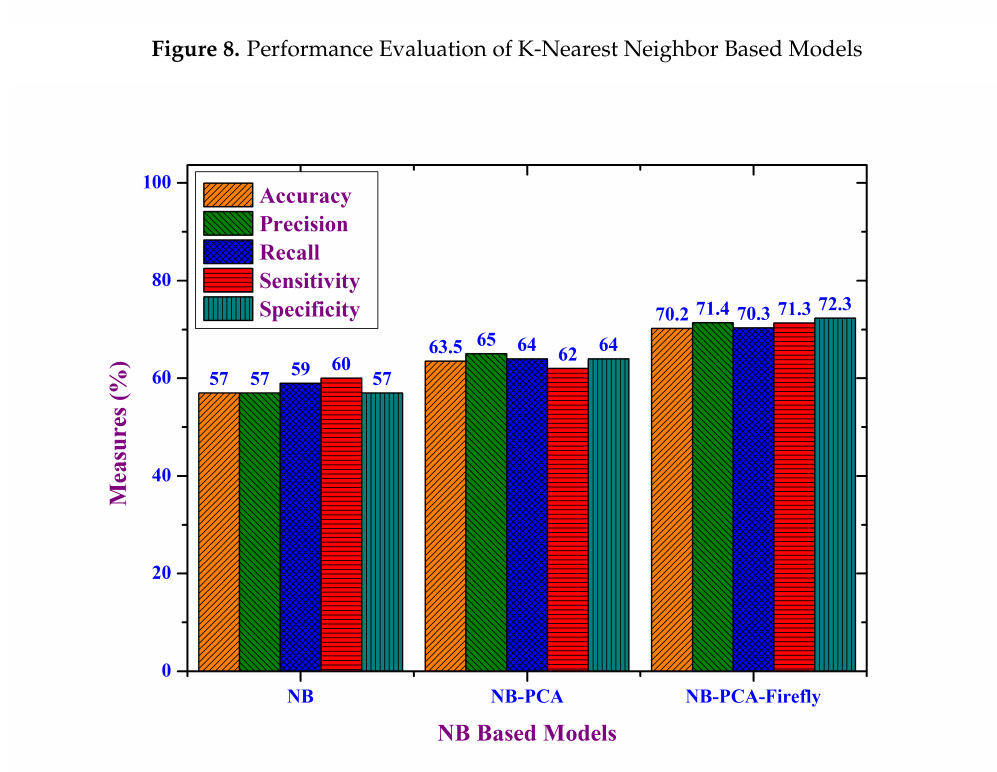
Figure 9. Performance Evaluation of Naive Bayes Based